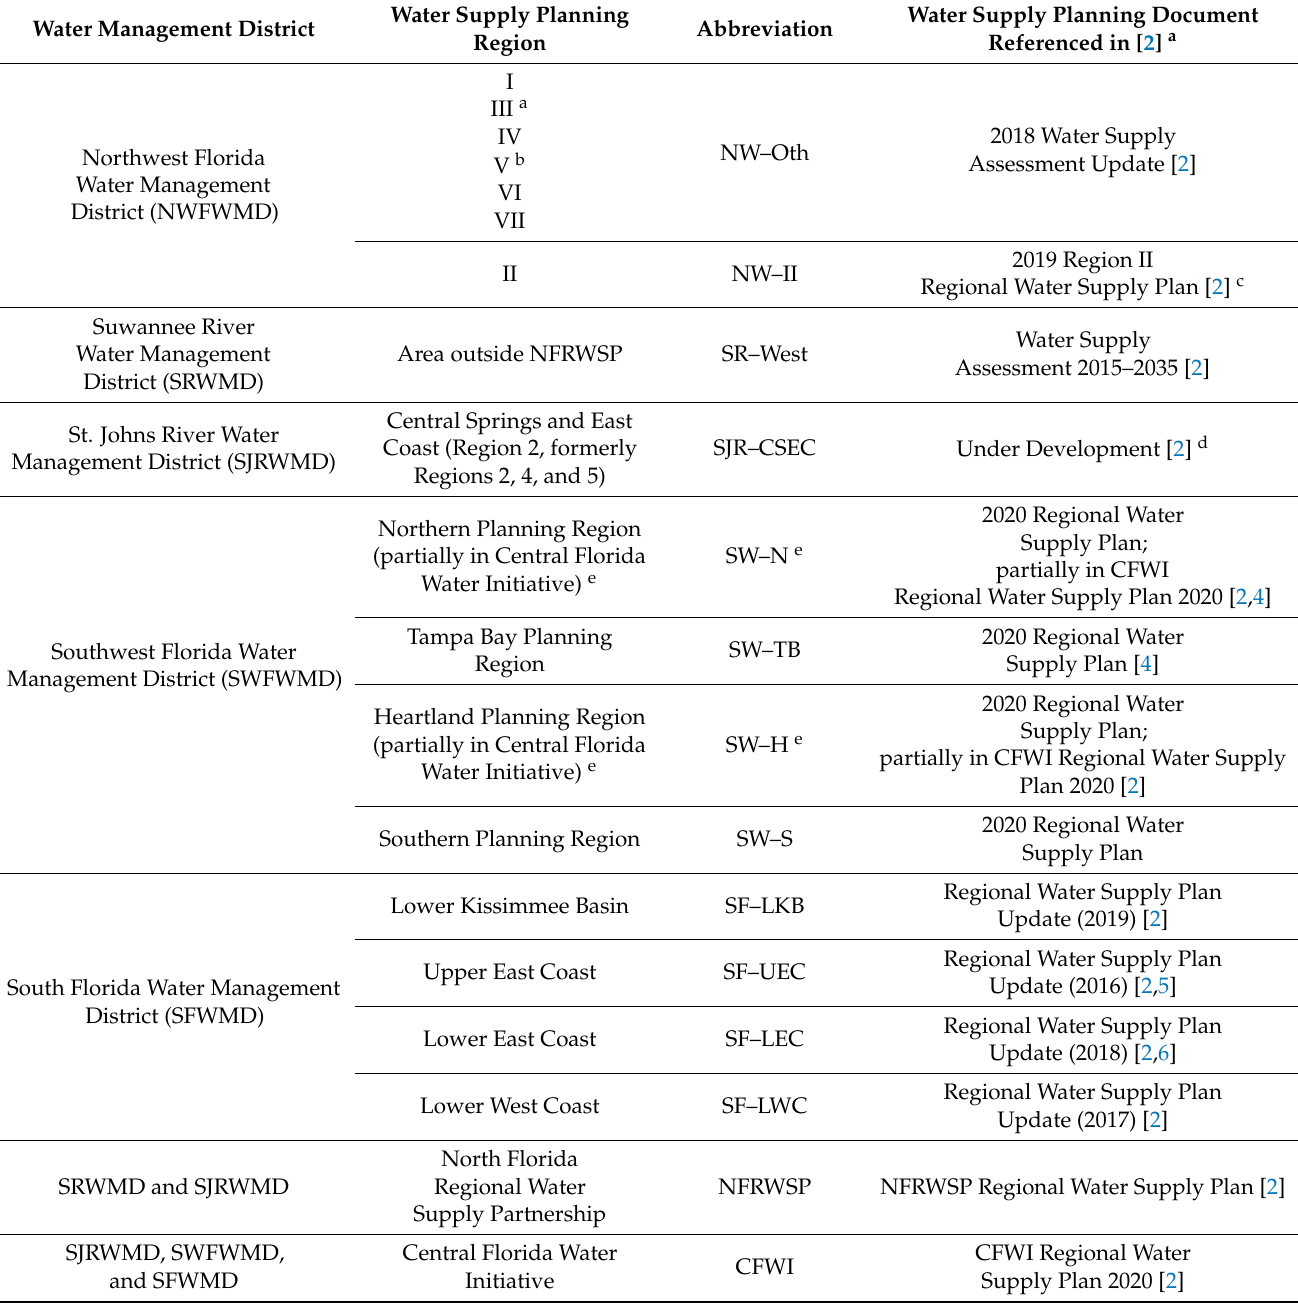
Table 1. Water Supply Planning Regions Considered in this